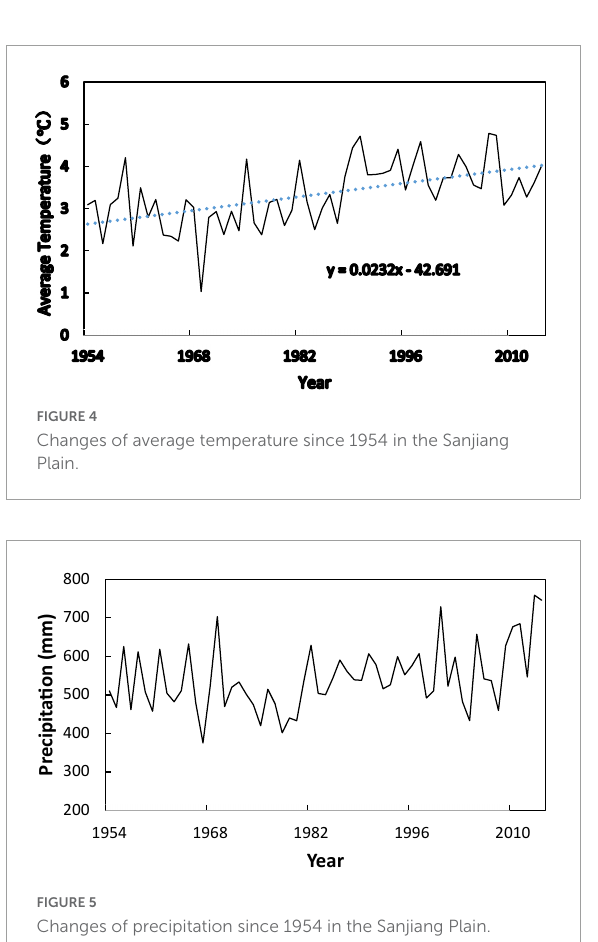
FIGURE5 Changes of precipitation since 1954 in the Sanjiang Plain.